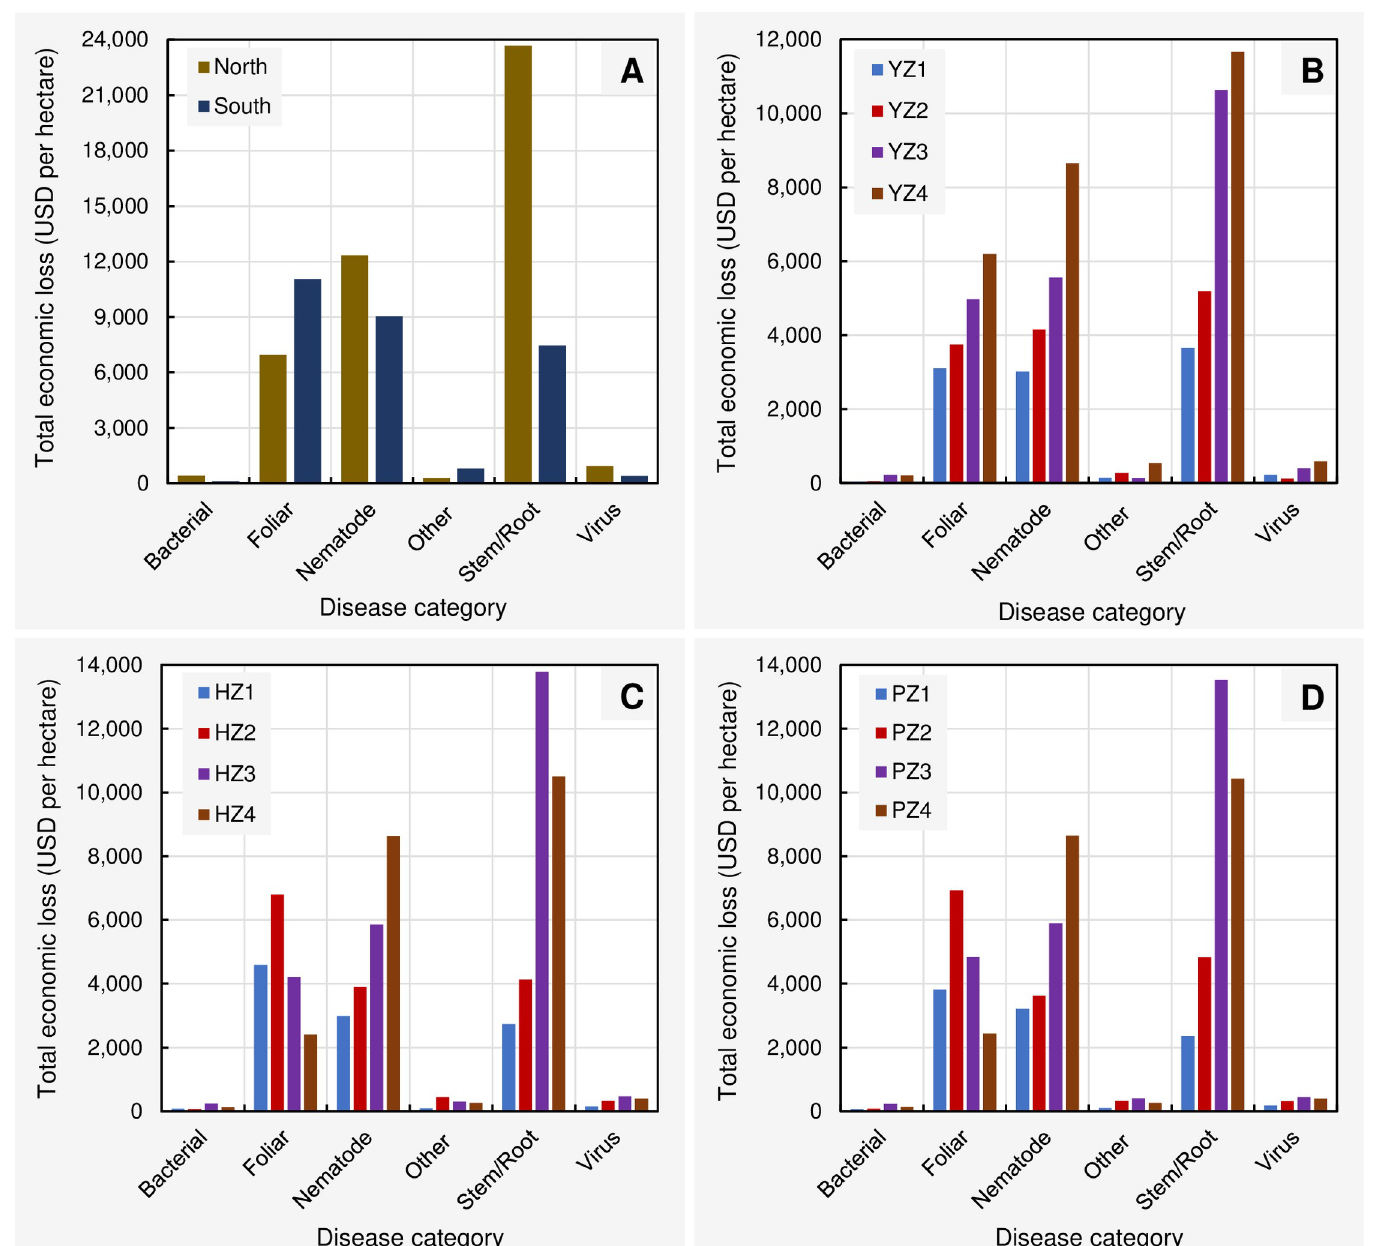
Fig 7. Comparison of the cumulative total per hectare economic loss (USD) from 1996 to 2016 due to disease categories at ( A ) northern and southern US. ( B ) different yield zones (1–4). ( C ) different harvest zones (1–4). ( D ) different production zones (1–4). Northern region = Illinois, Indiana, Iowa, Kansas, Michigan, Minnesota, Nebraska, North Dakota, Ohio, Pennsylvania, South Dakota, and Wisconsin; Southern region = Alabama, Arkansas, Delaware, Florida, Georgia, Kentucky, Louisiana, Maryland, Mississippi, Missouri, North Carolina, Oklahoma, South Carolina, Tennessee, Texas, and Virginia; Yield/Harvest/Production zones = represent four levels (zone 1–4) based on the quartiles within a data base containing 588 yield (kg/ha)/harvest area (ha)/production (MT) data points (588 = 21 years × 28 states). Within this data base, data points from the minimum to the first quartile were classified as zone 1. Similarly, data points from the first quartile to median, median to the third quartile, and > third quartile were respectively classified as zones 2, 3, and 4. Bacterial = Bacterial blight; Foliar = Anthracnose, Cercospora leaf blight (purple seed stain), Diaporthe-Phomopsis, Downy mildew, Frogeye leaf spot, Pod and stem blight, Rhizoctonia aerial blight, Septoria leaf spot, and Soybean rust; Nematodes = Heterodera glycine (soybean cyst nematode), Meloidogyne spp. (root-knot nematodes), Rotylenchulus reniformis (reniform nematode), Belonolaimus longicaudatus (sting nematode), Helicotylenchus spp. (spiral nematodes), Hoplolaimus spp. (lance nematodes), Paratrichodorus spp. (stubby root nematodes), and Pratylenchus spp. (lesion nematodes); Stem/Root = Brown stem rot, Charcoal rot, Fusarium wilt, Phytophthora root and stem rot, Sclerotinia stem rot (white mold), Seedling diseases (caused by a complex of organisms such as multiple species of Fusarium, Pythium, Phomopsis, and/or Rhizoctonia solani), Southern blight, Stem canker, and Sudden death syndrome; Virus = Alfalfa mosaic virus , Bean pod mottle virus , Bean yellow mosaic virus , Peanut mottle virus , Soybean dwarf virus , Soybean mosaic virus , Soybean vein necrosis virus , Tobacco ringspot virus , Tobacco streak virus , and Tomato spotted wilt virus ; Other diseases = black root rot, Cercospora leaf blight, Cylindrocladium parasticum (red crown rot), green stem syndrome, Neocosmospora root rot, Pythium root rot, target spot, and Texas root rot.